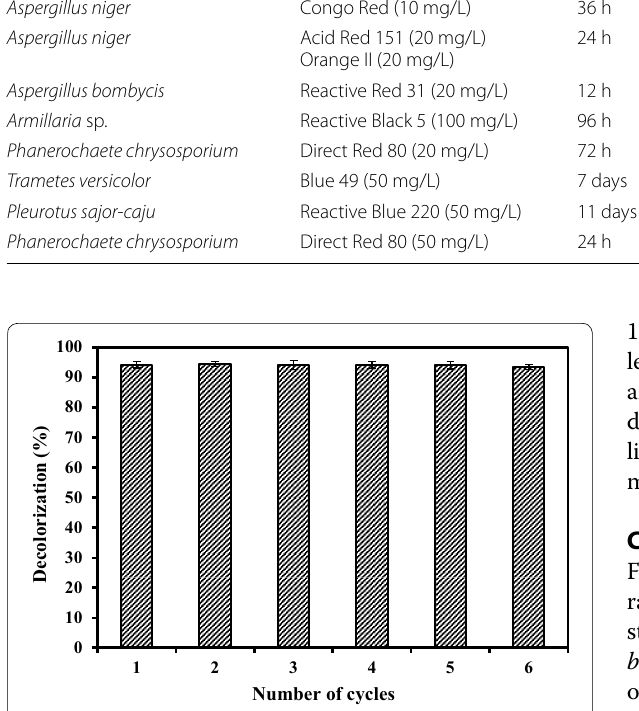
Fig. 6 Recycling of fungal pellets in aerobic bioreactor at 12 h of